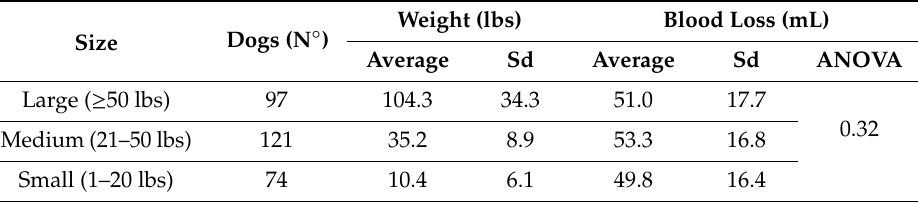
Table 2. Data about average blood loss according to dogs’ size. Table 3. Data about average blood loss according to cats’ size.